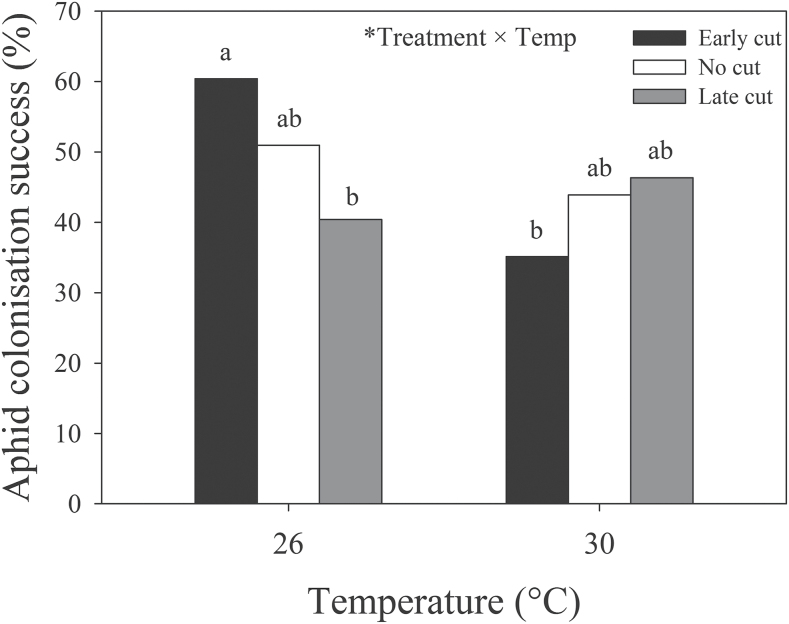
Effects of root cutting on aphid colonization success (i.e. percentage of plants with aphids present upon harvest) under ambient and elevated temperatures. A statistically significant effect is indicated by * (P<0.05). Bars with the same letters were not significantly different (P<0.05).